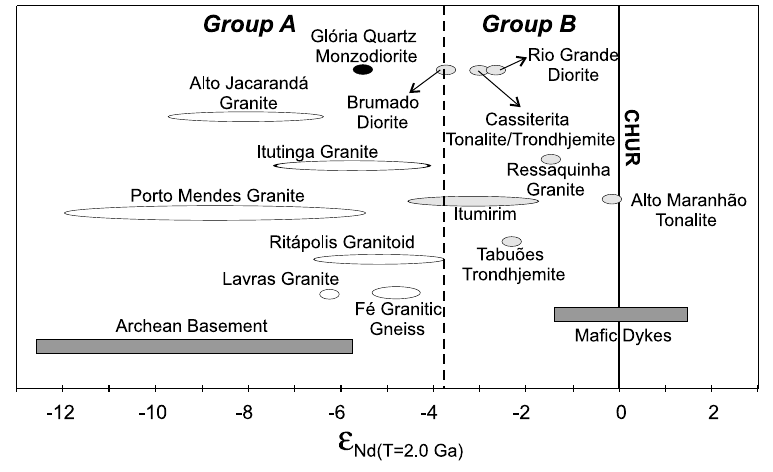
Fig. 7 – Isotopic characteristics [ ε Nd(T). Reference Time = 2.0] of the Mineiro belt plutonic intrusions, Archean country rocks and mafic dykes (adapted from Noce et al. 2000), assuming a homogeneous isotopic evolution at the reference time for the oldest Paleoproterozoic plutons, as well as for the Archean crust. Data compilation from the Archean basement and Paleoproterozoic mafic dykes are also shown (J.P.P. Pinese, unpublished data, Carneiro et al. 1998, Teixeira et al. 1998, Campos et al.